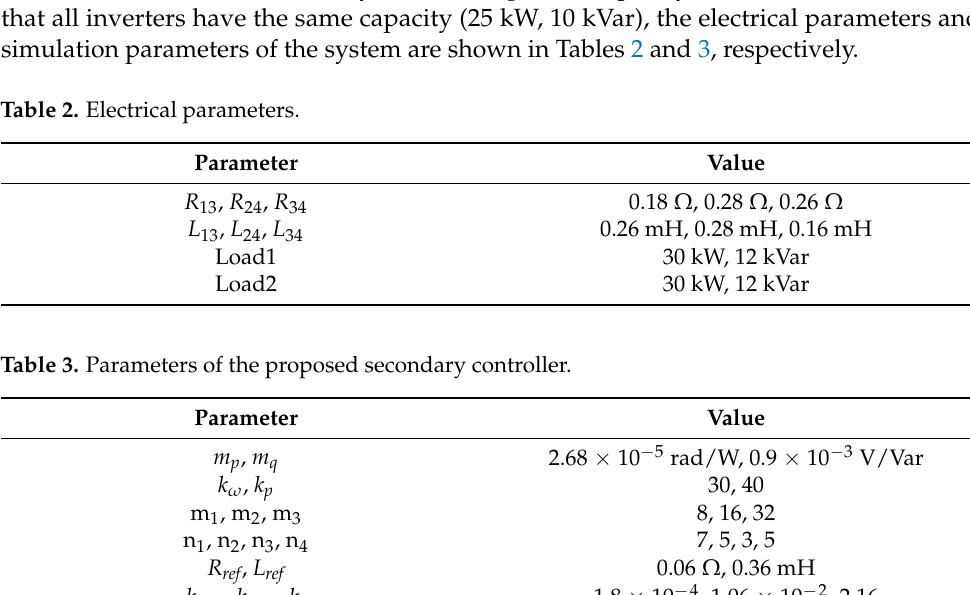
Figure 3. Simulation test setup.